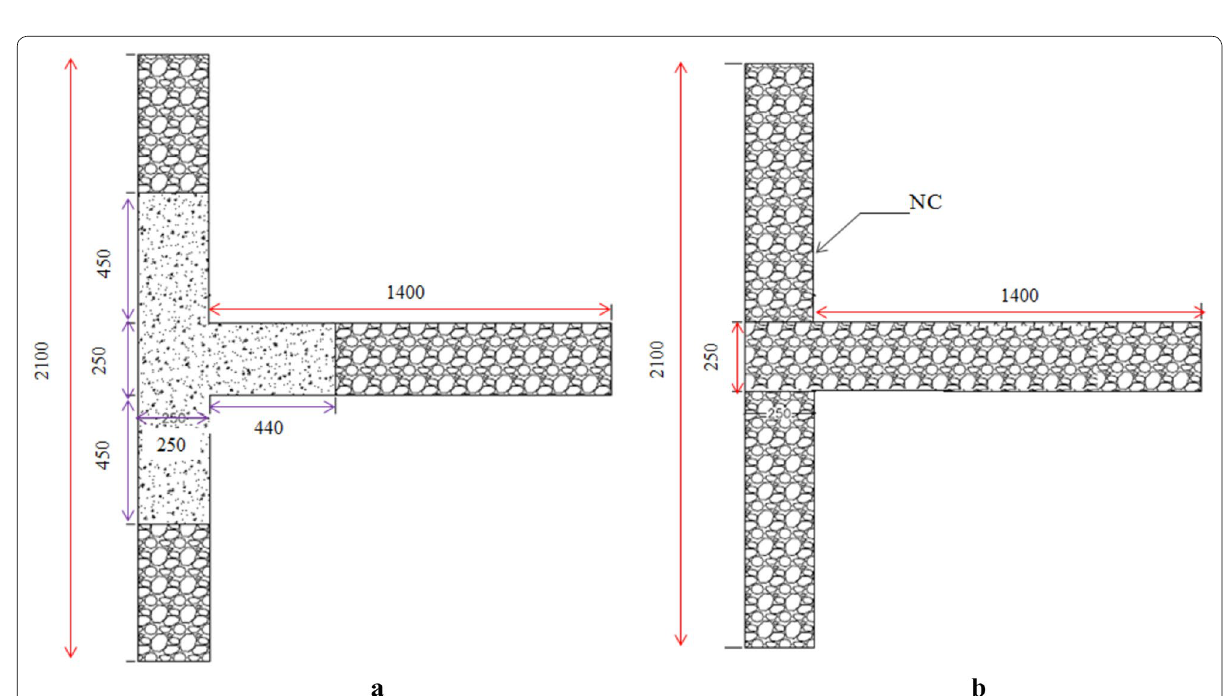
Fig. 10 Concrete pouring pattern for beam-column specimen: a concrete pouring pattern HPFRCC; b concrete pouring pattern